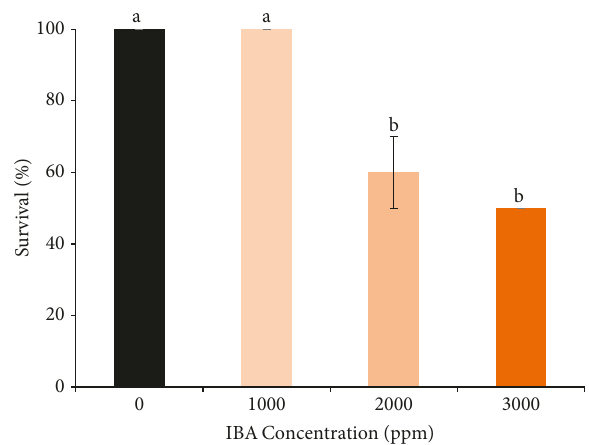
Figure 2: Root traits of T. cacao cuttings, according to IBA dose, 62 days after rooting induction. Columns with the same letter indicate nonsignificant differences between the treatments (Tukey’s HSD, p < 0 . 05). (a) Rooting percentage. (b) Number of roots. (c) Root length. Means and standard error ( n � 30).